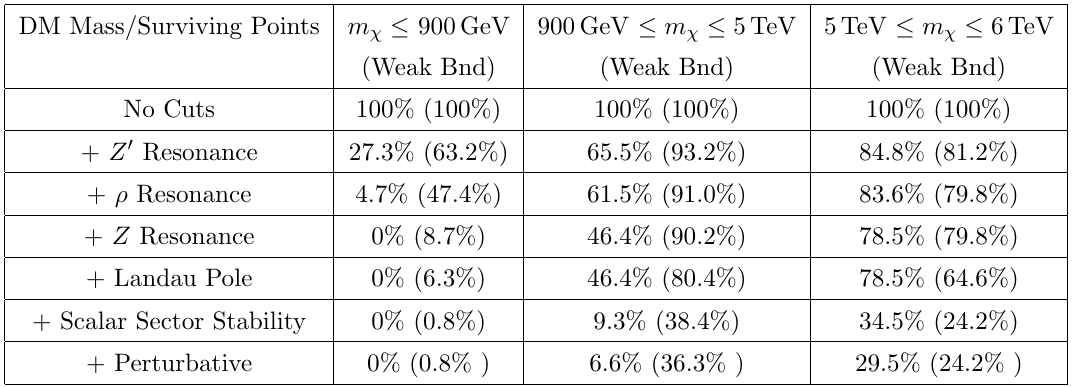
Table 2 . Fraction of sampled points surviving various resonance and RGE cuts. Values in parenthe- sis correspond to the secondary sampling using the reduced bound analysis described in section 5. The (cid:12)nal row contains the fraction of points surviving all